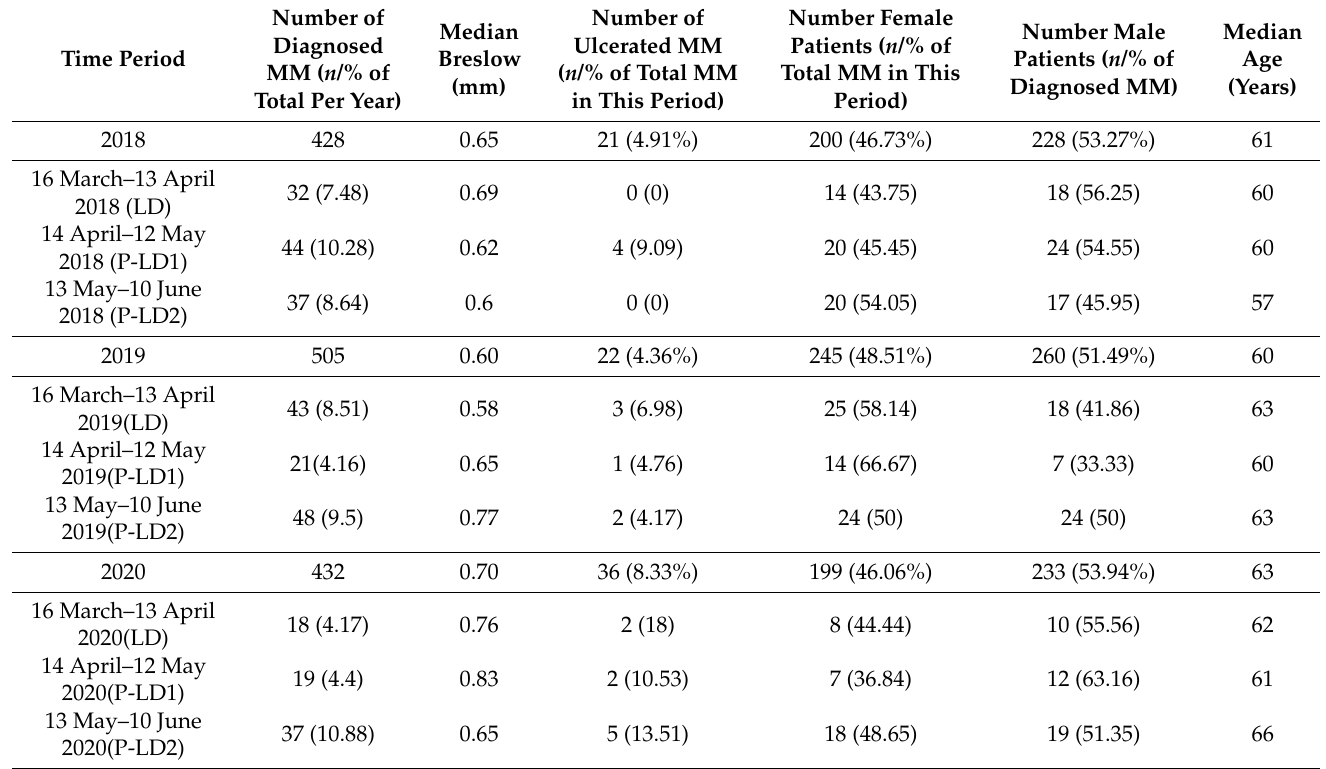
Table 1. Primary melanoma diagnoses from 2018 to 2020: patient and tumor characteristics.